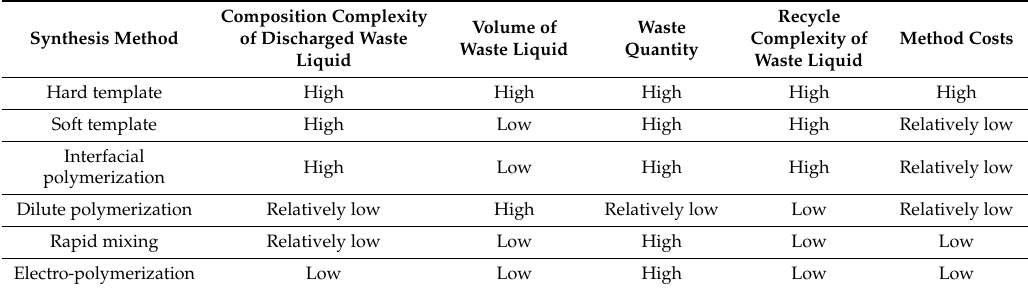
Table 1. Comparison di ff erent 1-D nano-PANI synthetic methods on the aspects of composition complexity of waste water, volume of waste water, waste quantity, recycle complexity of waste water, and method